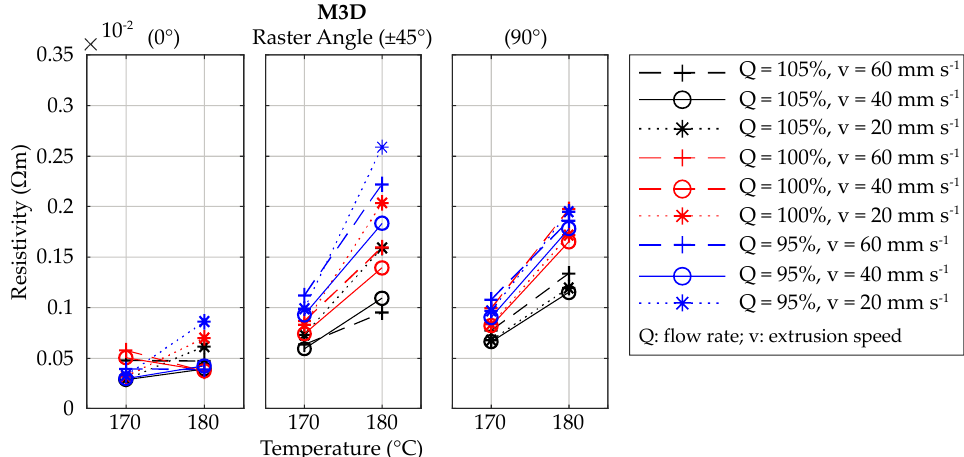
Figure 13. Dependencies of the resistivity of M3D regarding temperature, extrusion speed and flow rate structured by raster angle.